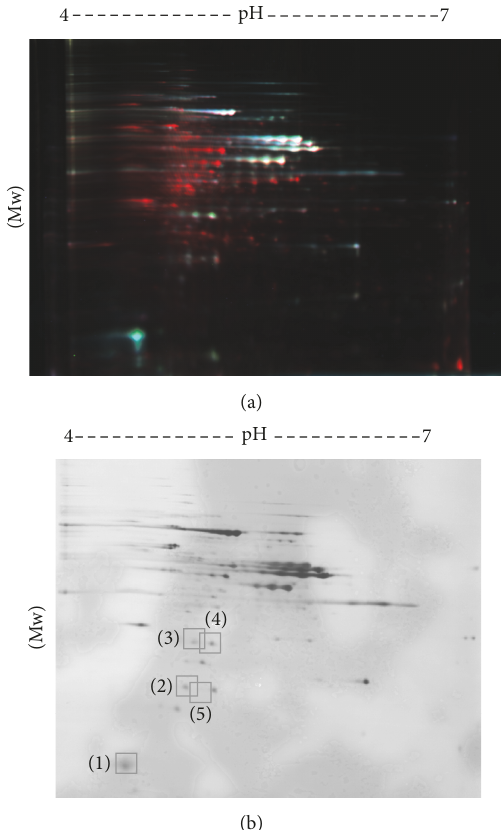
Figure 2: Results from the analysis with DeCyder 2D Differential Analysis Software (GE Healthcare). Sample 1 is HSP 9/12 (Q6FPF6); sample 2 is redoxin